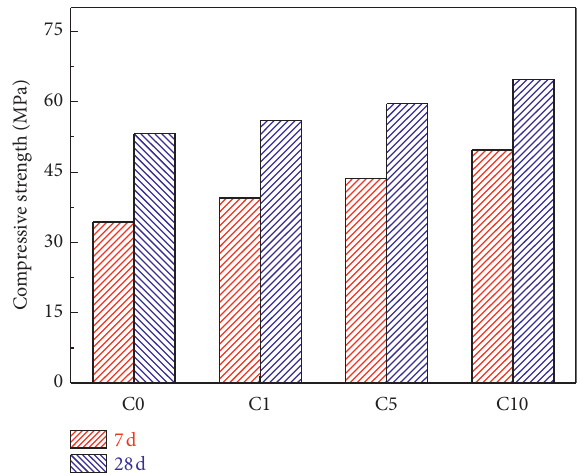
Figure 4: Compressive strength of CNT-mortar samples with the various dosage of CNT-COOH after 7 and 28 days of curing time (C0: 0%, C1: 0.01%, C5: 0.05%, and C10 :0.10% of CNT-COOH by weight of cement).